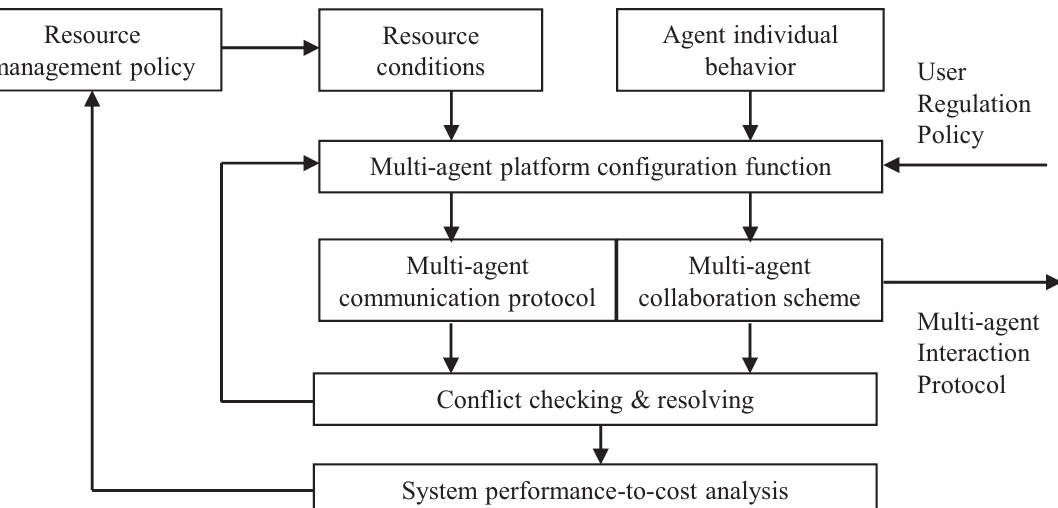
Multi-agent platform configuration